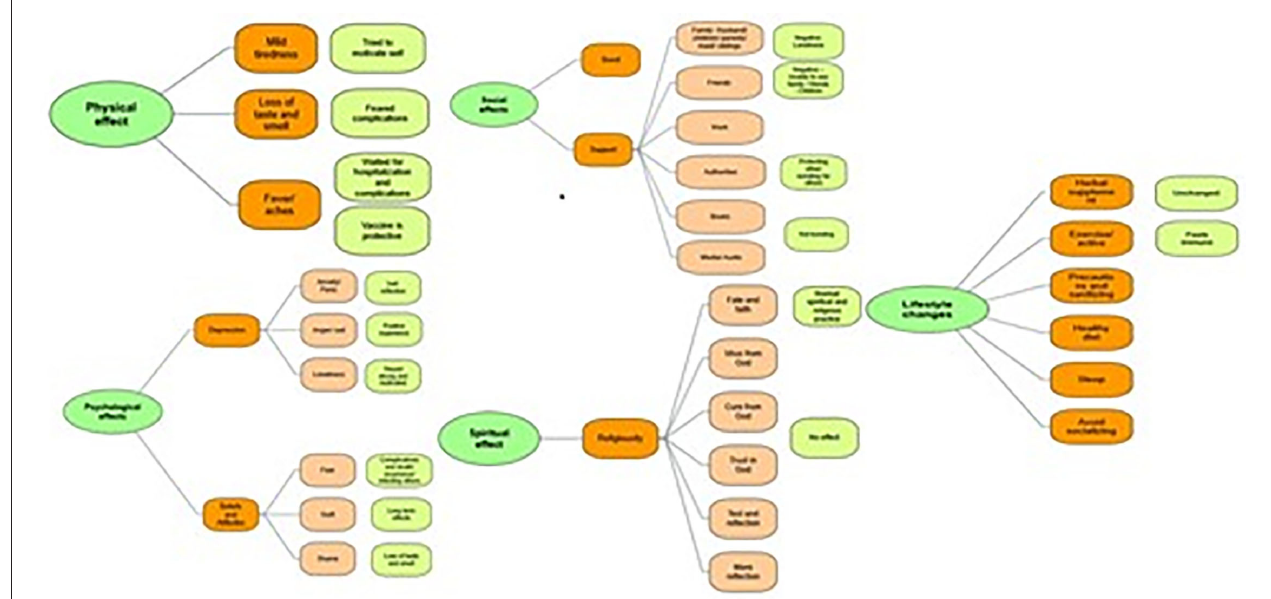
FIGURE 1 | Themes tree * . * Physical, social, psychological, physical, and lifestyle impact by NVIVO.